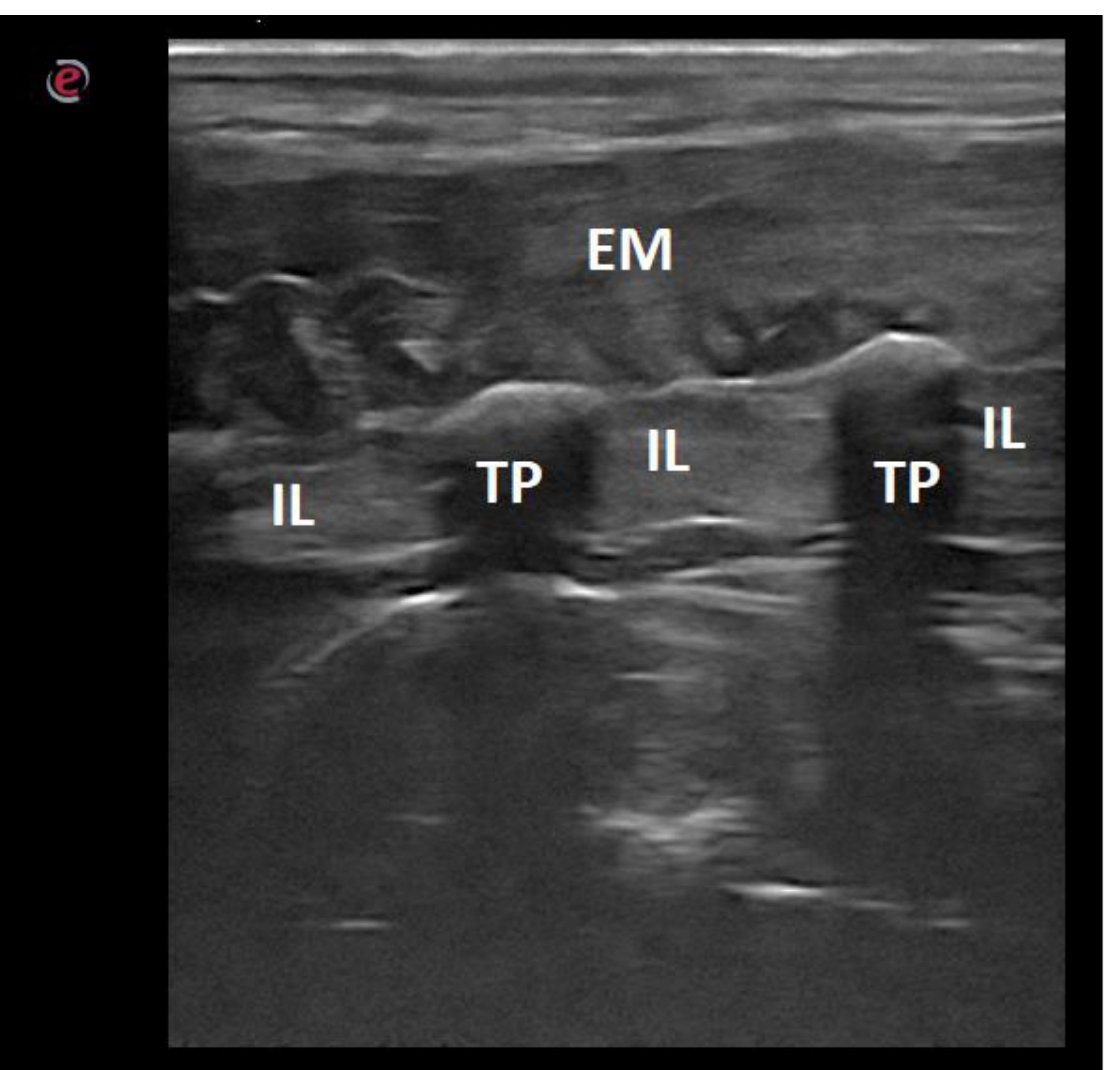
Figure 9. Ultrasonographic image of the lumbar spine of a dog in the longitudinal paramedian plane on the lateral side: EM — epaxial muscles; IL — intertransverse ligament; TP — transverse process.